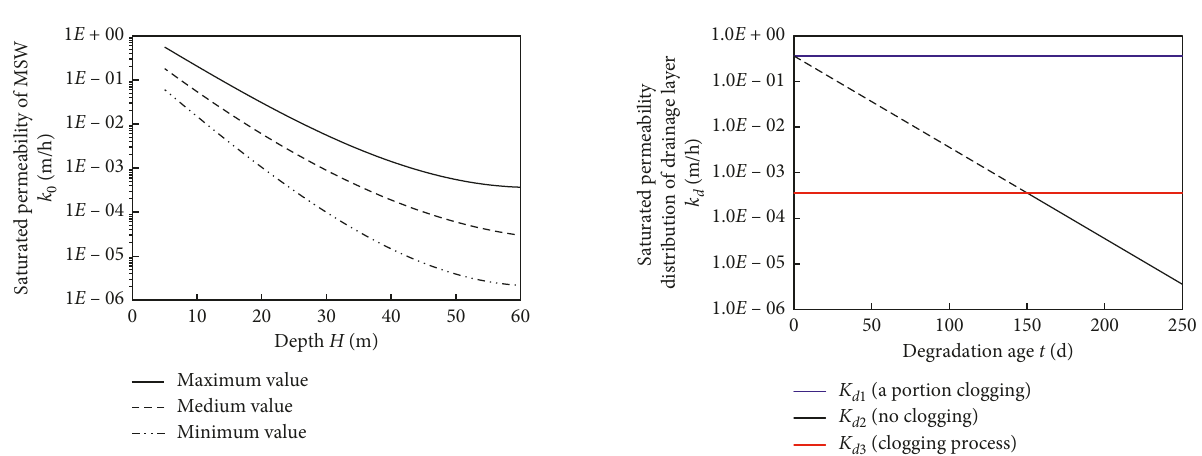
Figure 2: Initial saturated permeability distribution of MSW in the spatial domain [14].